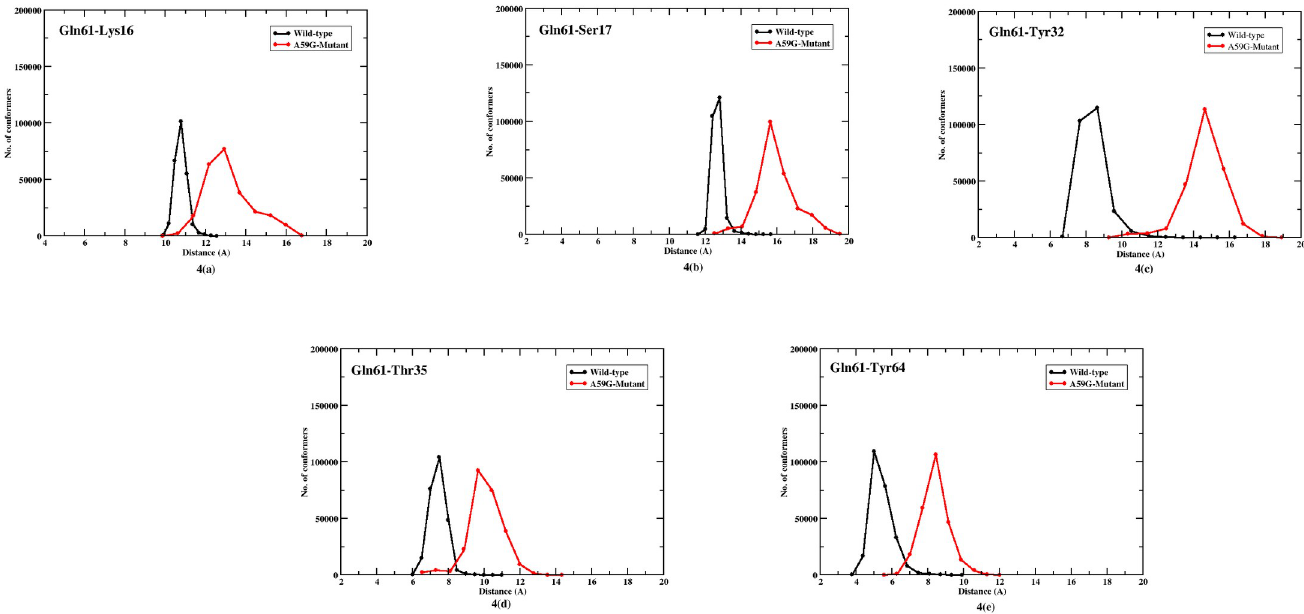
Fig 4. 2-D plot showing number of conformers for Gln61 residue’s interaction with Lys16, Ser17, Thr35, Tyr32 and Tyr64. Black and red lines represent trends for the wild-type and mutant systems, respectively.